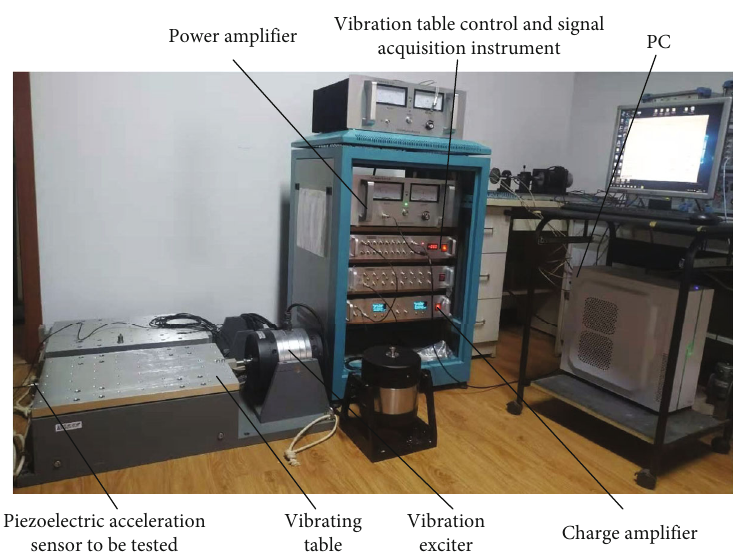
Figure 16: Physical diagram of sensor experimental test